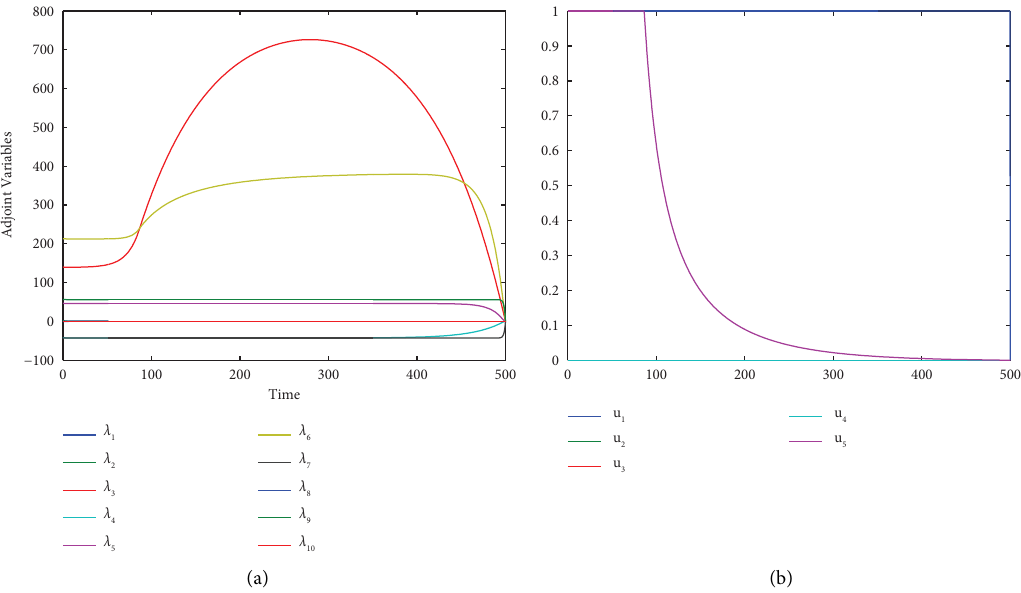
Figure 3: Plots of adjoint variables and control profles for the best strategy in combating spread of HIV-TB